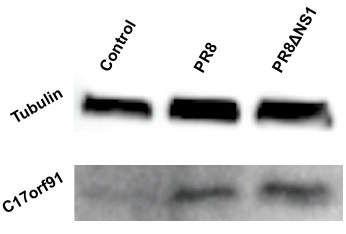
Figure 4. The endogenous micropeptide encoded by MIR22HG is upregulated upon infection. Western blot of MIR22HG peptide upon infection. The MIR22HG peptide is detectable in the absence of infection, and upon infection with PR8 or PR8 Δ NS1 at a MOI of 1 the expression level increases. MOI: multiplicity of infection.